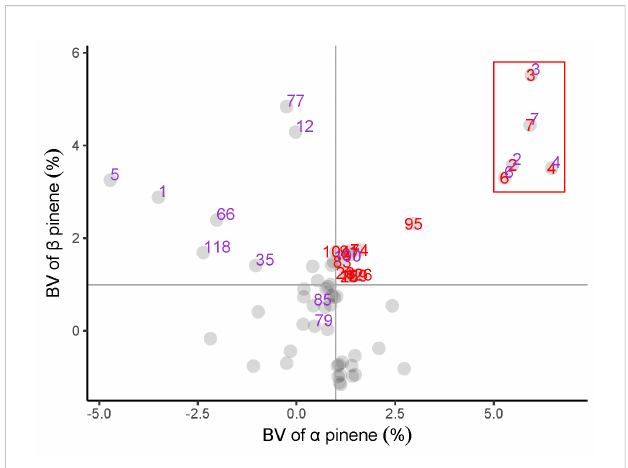
FIGURE 5 Relationship between a pinene, b pinene, abietic acid and levoprimaric acid BV of the slash pine family. Each large gray dot represents one family. Red label: BV of a pinene, b pinene above the mean value; Purple label: BV of abietic acid and levoprimaric acid above the mean value. A family with two color tags in the red box was considered to perform excellently. The mean BV of a pinene and b pinene are displayed as a gray solid